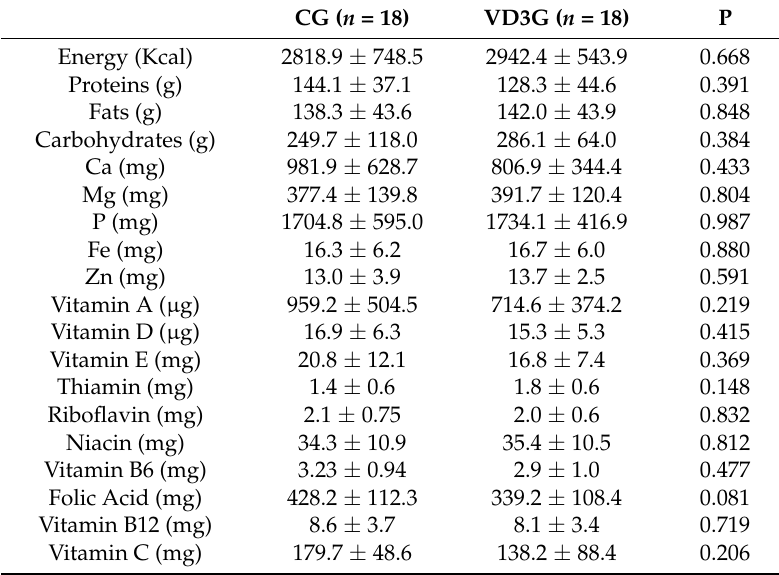
Table 4. Energy and micronutrients intake in control group (CG) and vitamin D3 group (VD3G) during 8 weeks of